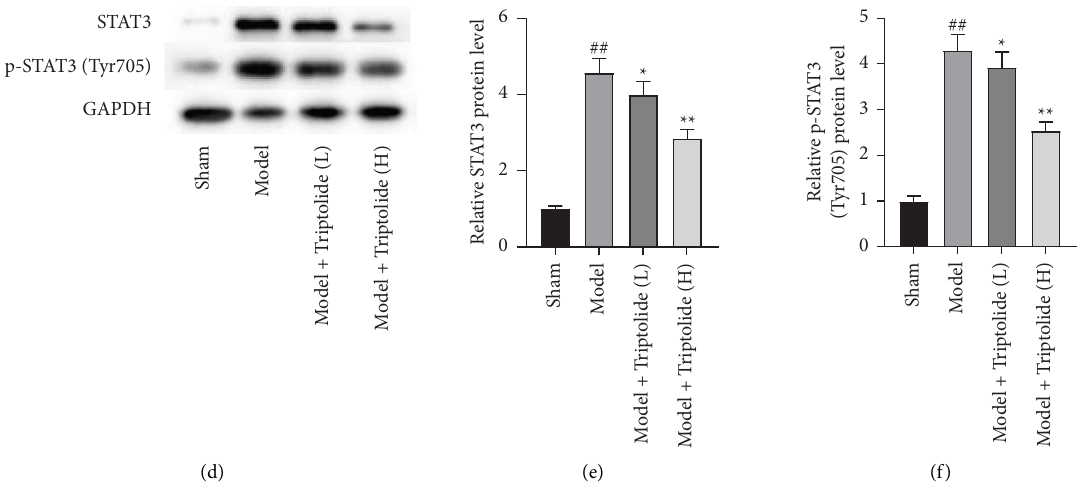
Figure 7: Efects of triptolide on miR-204-5p and STAT3 expression in psoriasis-like lesions. (a and b) After collecting the dorsal skin of mouse models in the indicated groups on the 8th day, RT-qPCR was performed for examining miR-204-5p and STAT3 expression. (c) Te expression correlation between miR-204-5p and STAT3 by Spearman’s correlation analysis. (d–f) Te protein levels of STAT3 and p- STAT3 in the dorsal skin of mouse models tested via Western blot analysis. Each column is representative of data obtained from a minimum of 8 animals. ## P < 0 . 01 compared to the sham group; ∗ P < 0 . 05, ∗∗ P < 0 . 01 compared to the model